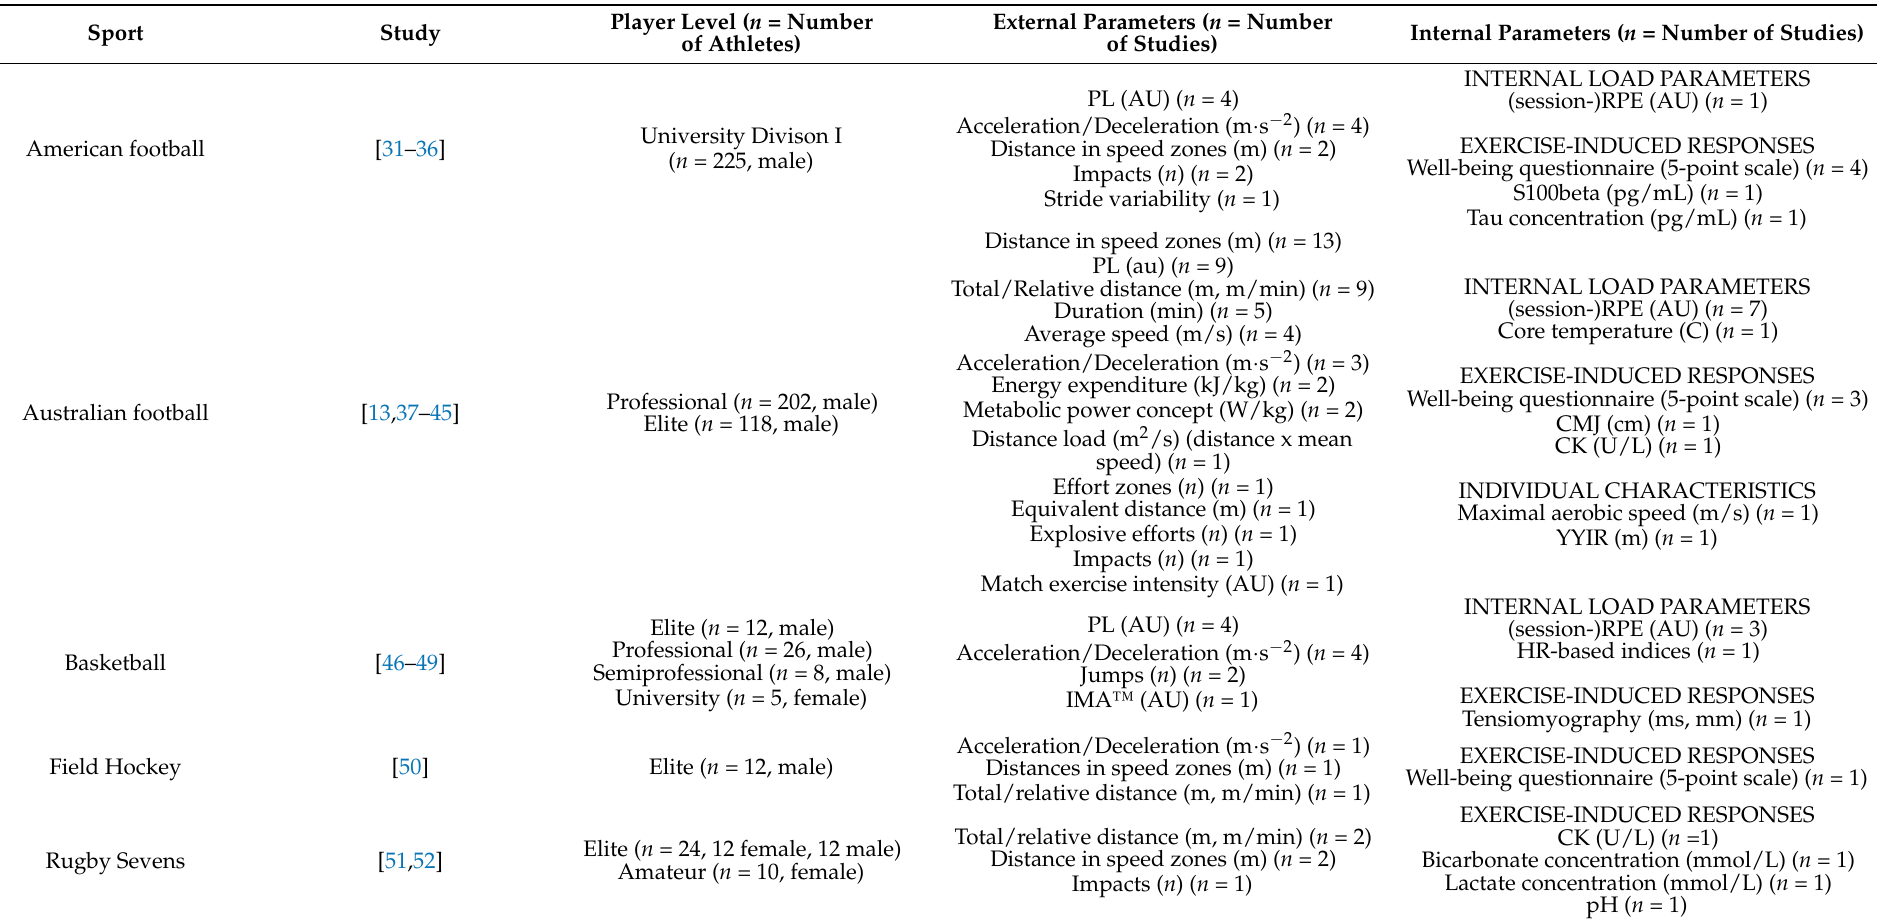
Table 3. Studies included in this systematic review sorted by type of team sport. The table includes information about the player level and the parameters